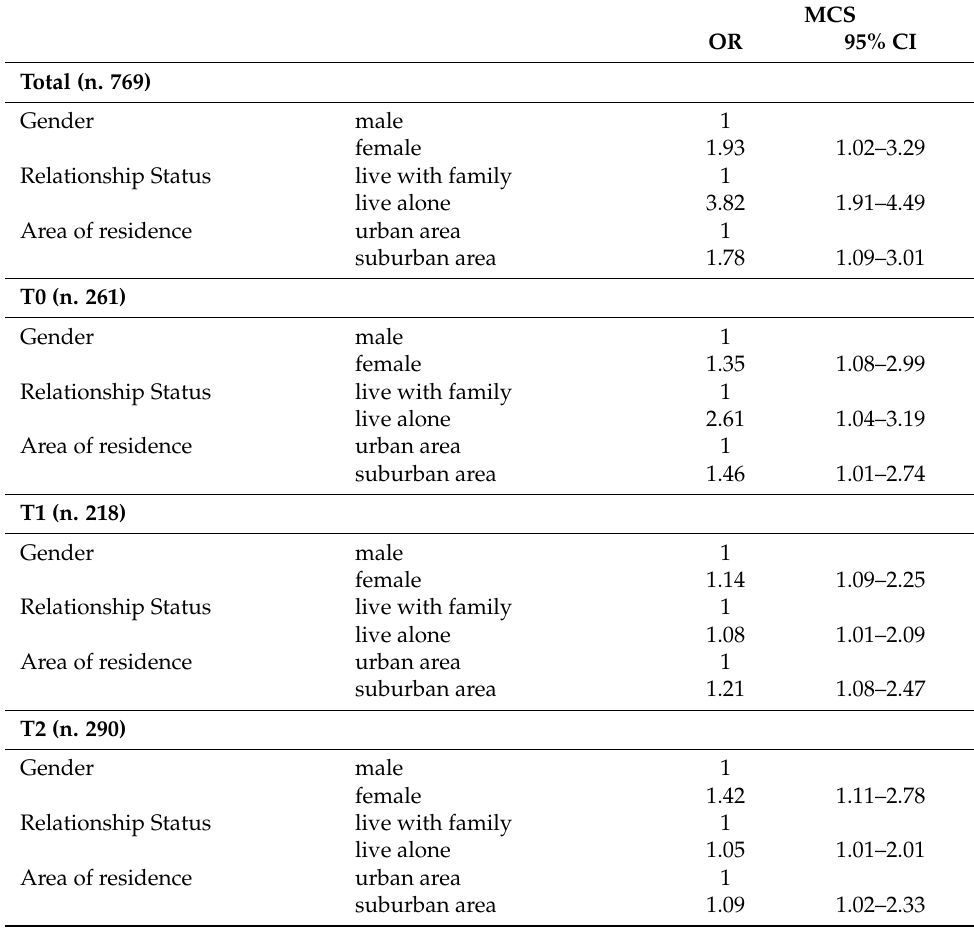
Table 4. Logistic regression model relating groups of variables and